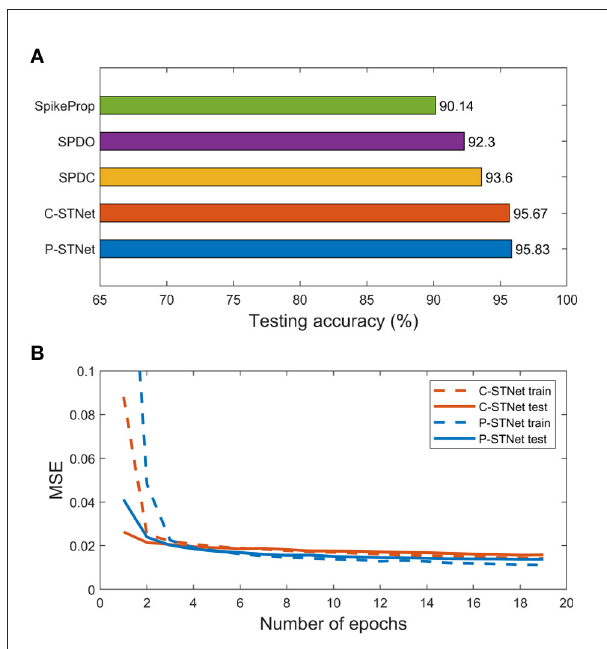
FIGURE10 Experimental results on the MNIST dataset. (A) : Testing accuracies of the five approaches. (B) : MSE curves of the two STNets.